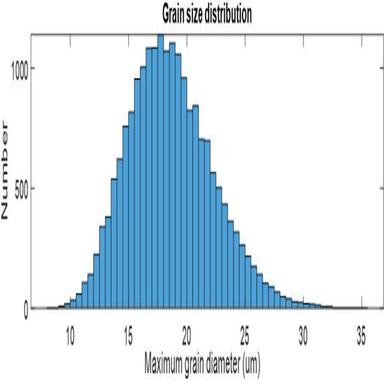
Grain size distribution for modeling.